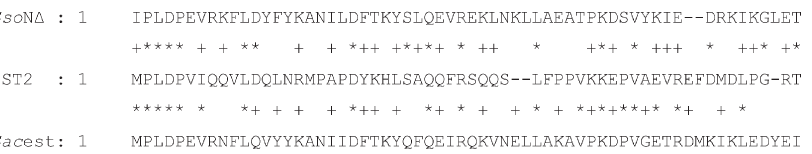
Figure 3. Sequence alignment of the N ter- mini of the putative Sso N Δ long, the esterase EST2 from A . acidocaldarius , and the putative S . acidocaldarius esterase from SAC1105 belonging to the HSL fam- ily. Asterisks and crosses indicate identical and similar residues, respectively, between EST2 and the two other